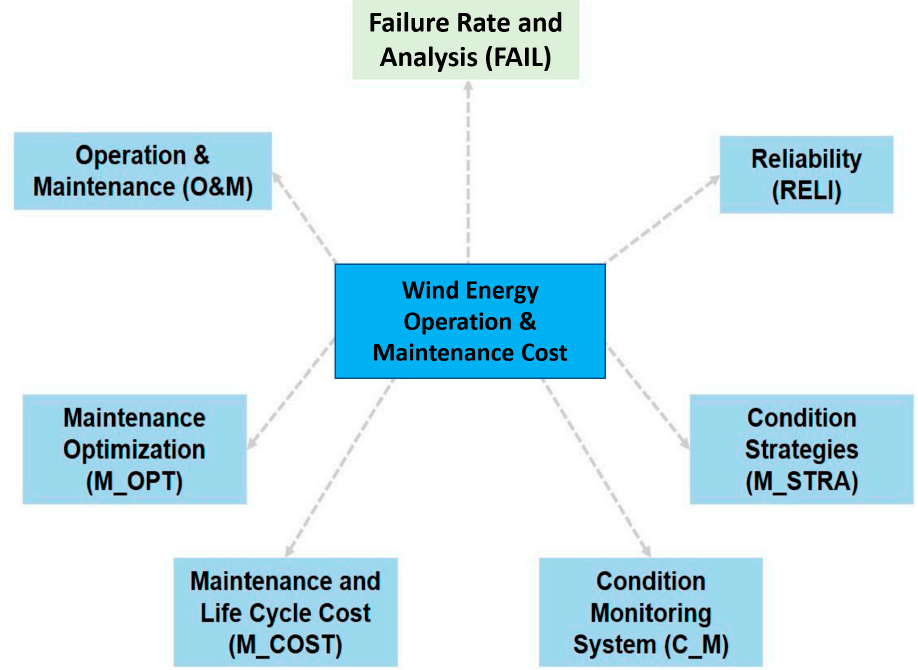
Figure 20. Overview of wind energy O&M cost fields.